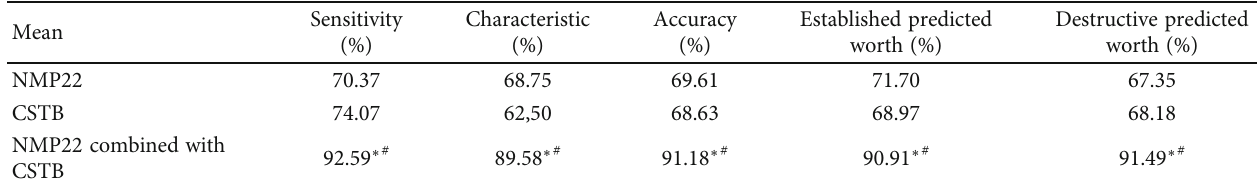
Table 5: Contrast by the sensitivity, characteristic, accuracy, established predicted worth, and destructive predicted worth of preoperative NMP22 and CSTB single testing and combined testing in assessing postoperative recurrence of bladder carcinoma.